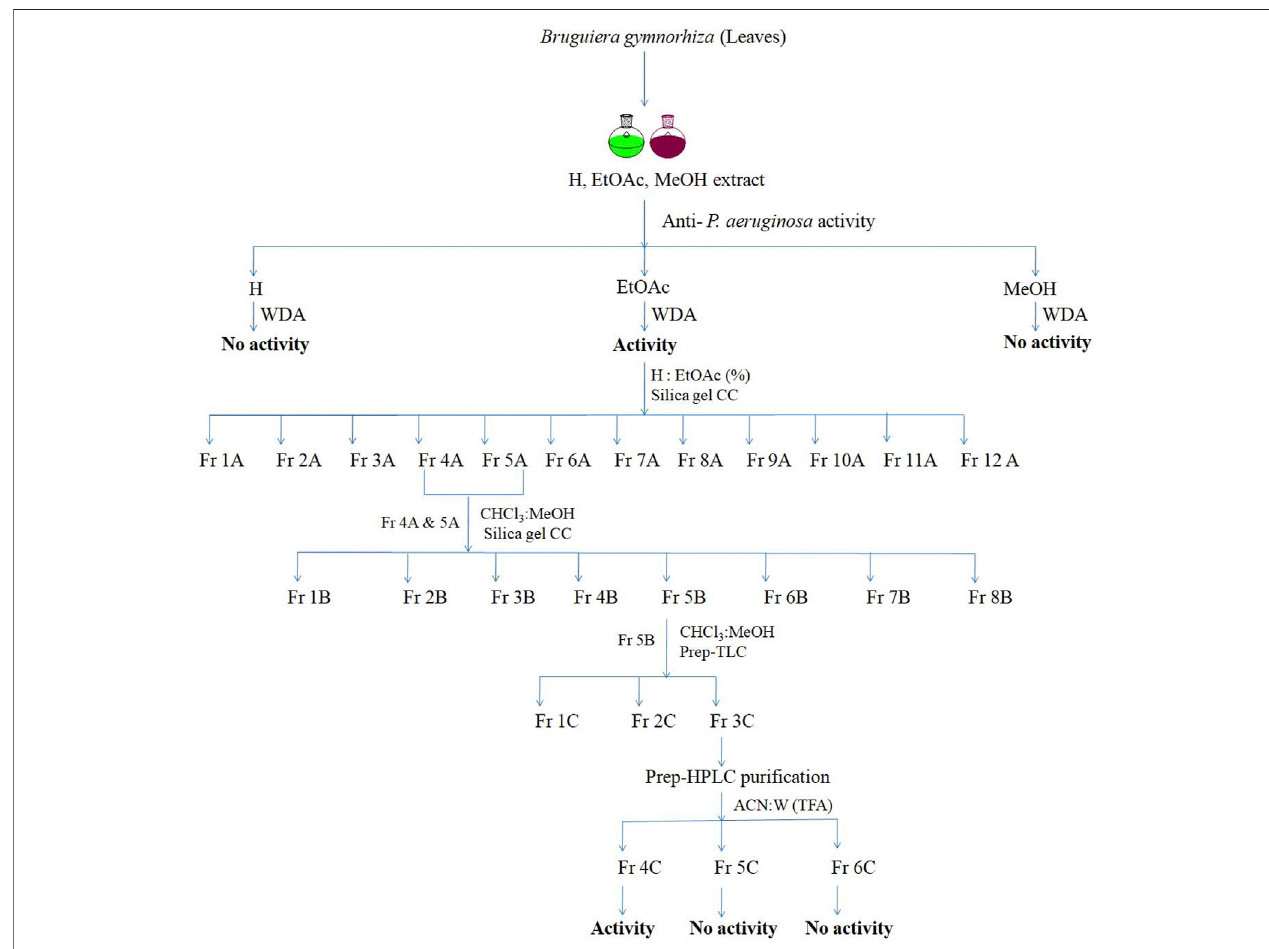
FIGURE 1 | Isolation scheme of active fraction BG138 from leaves of B. gymnorhiza . (CC, Column chromatography; H, Hexane; EtOAc, Ethyl acetate; MeOH, Methanol; CHCl3, Chloroform; ACN, Acetonitrile; W, Water; WDA, Well diffusion assay; TFA, Tri fl uroacetic acid).